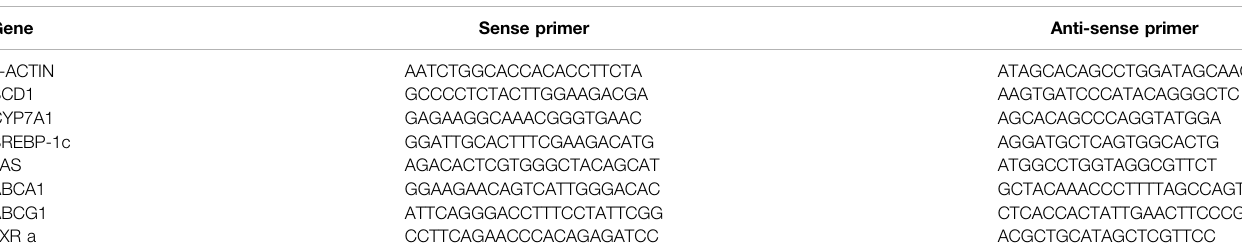
TABLE 2 | Sequences of the human primers used in real time